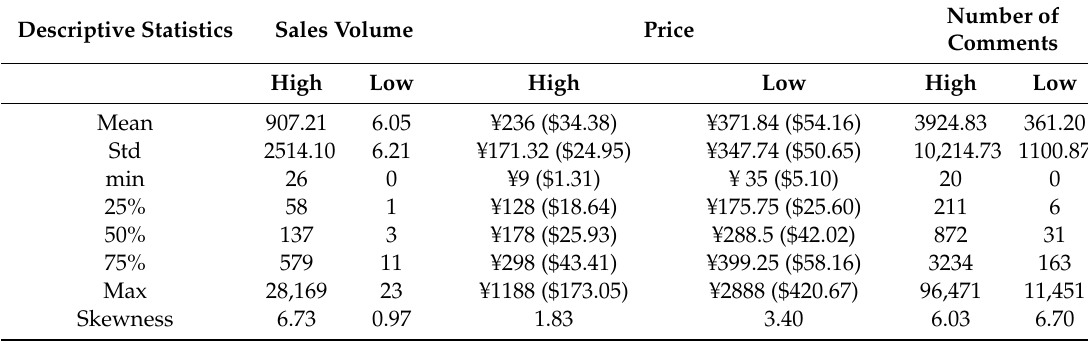
Table 1. Sales volume, price, and number of comments for sampled